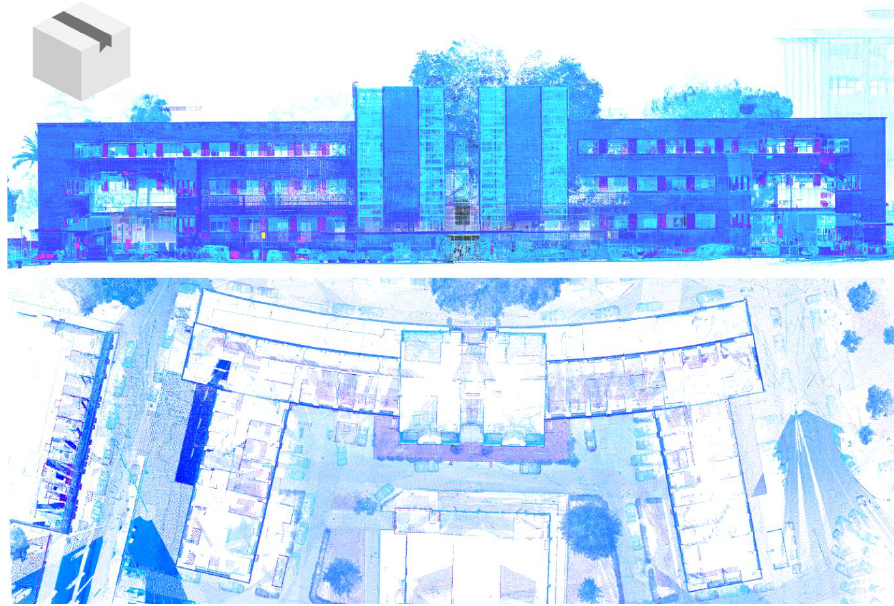
ISPRS Int. J. Geo-Inf. 2022 , 11 , x FOR PEER REVIEW